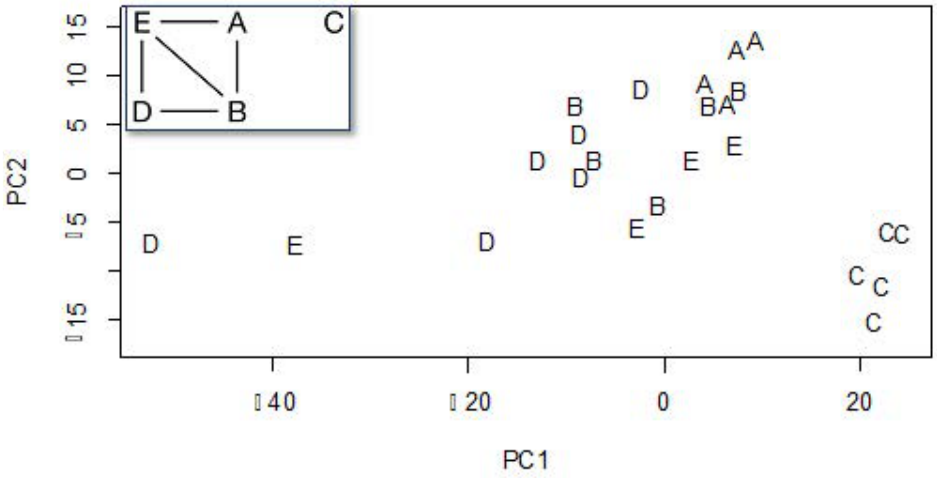
Figure 2. Principal components plot of compound variation among propolis samples (main figure), and pairwise analysis network graph (inset). Apiaries are represented by letter